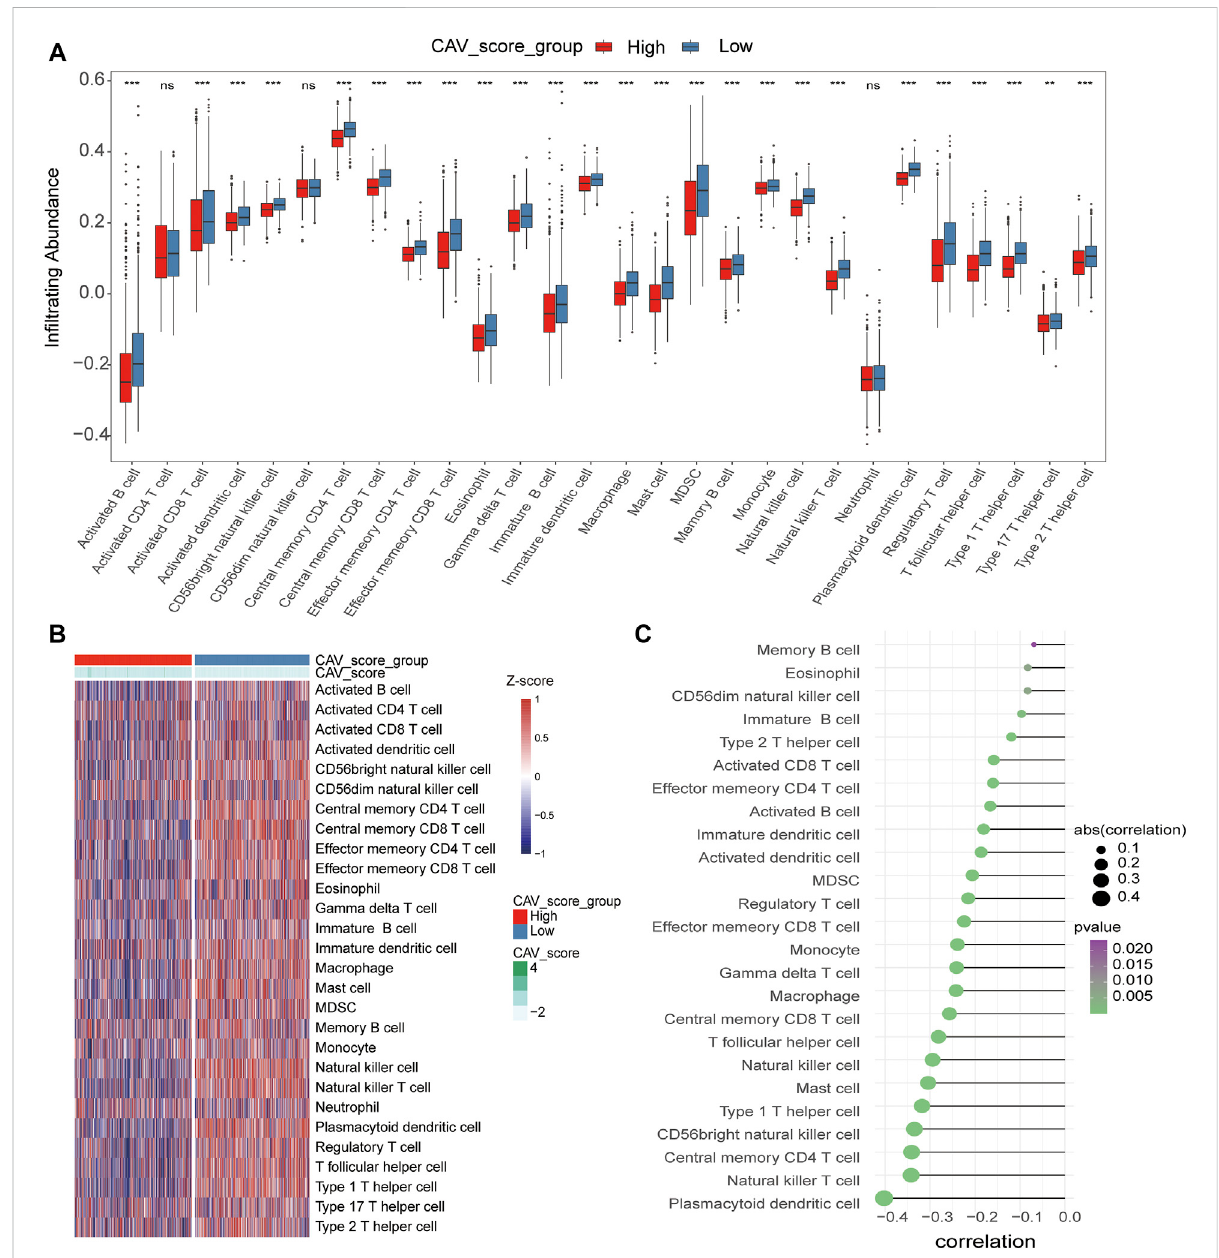
FIGURE 7 Correlations of CAVs with immune in fi ltration level in BC. (A,B) Identi fi cation of the relative in fi ltration of 28 types of immune cell subpopulations in high- and low-risk signature subgroups. (C) Correlation between immune in fi ltration cells and the risk score.